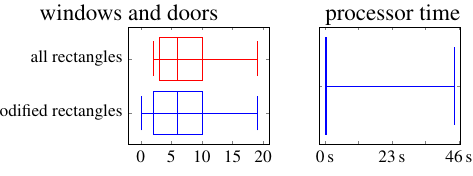
Figure 7. Box plots with data of 160 optimized facades.